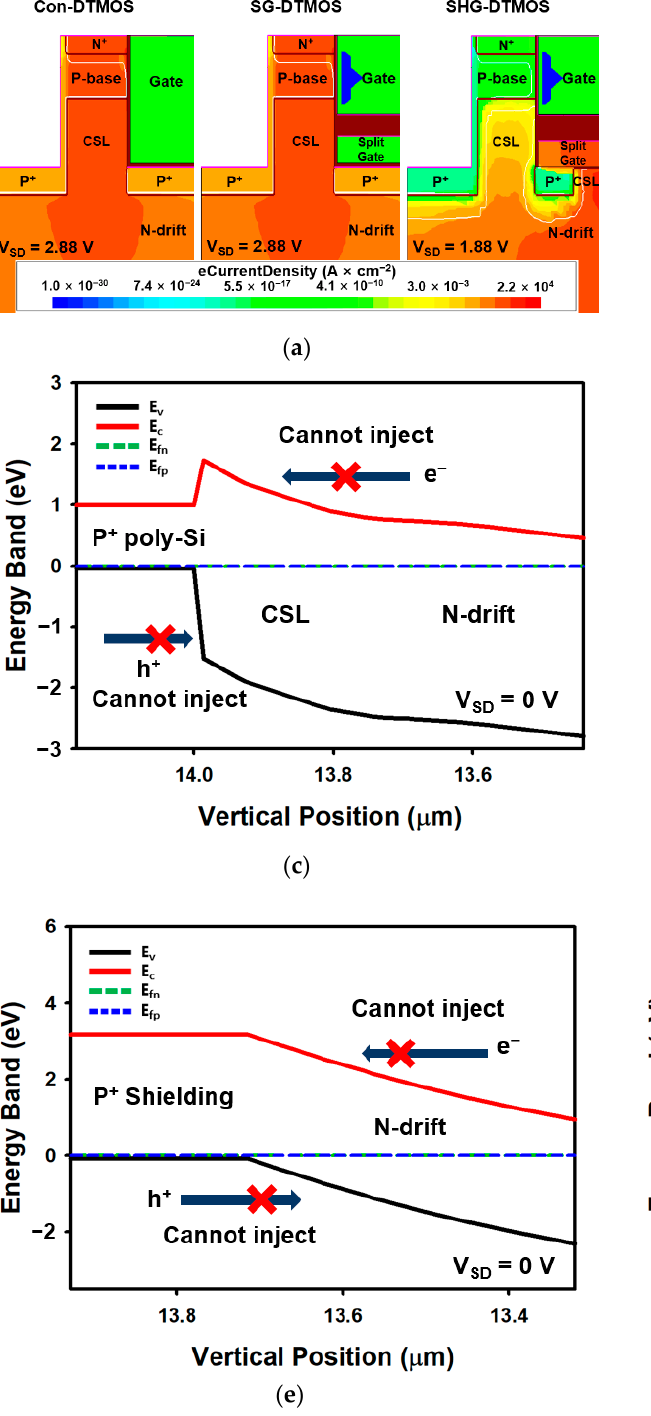
Figure 6. ( a ) The electron current distribution of Con-DTMOS, SG-DTMOS, and SHG-DTMOS. ( b ) The hole current distribution of Con-DTMOS, SG-DTMOS, and SHG-DTMOS. ( c ) The band diagram of SHG-DTMOS at V SD = 0 V. ( d ) The band diagram of SHG-DTMOS at V SD = 1.88 V. ( e ) The band diagram of SG-DTMOS at V SD = 0 V. ( f ) The band diagram of SG-DTMOS at V SD = 2.88 V.